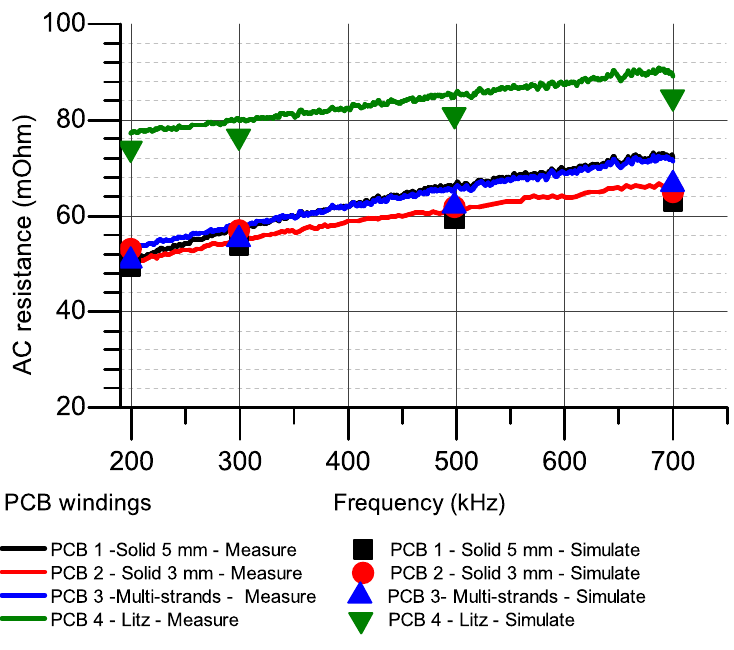
Figure 11. Measured and simulated AC resistances of 3-turn windings.